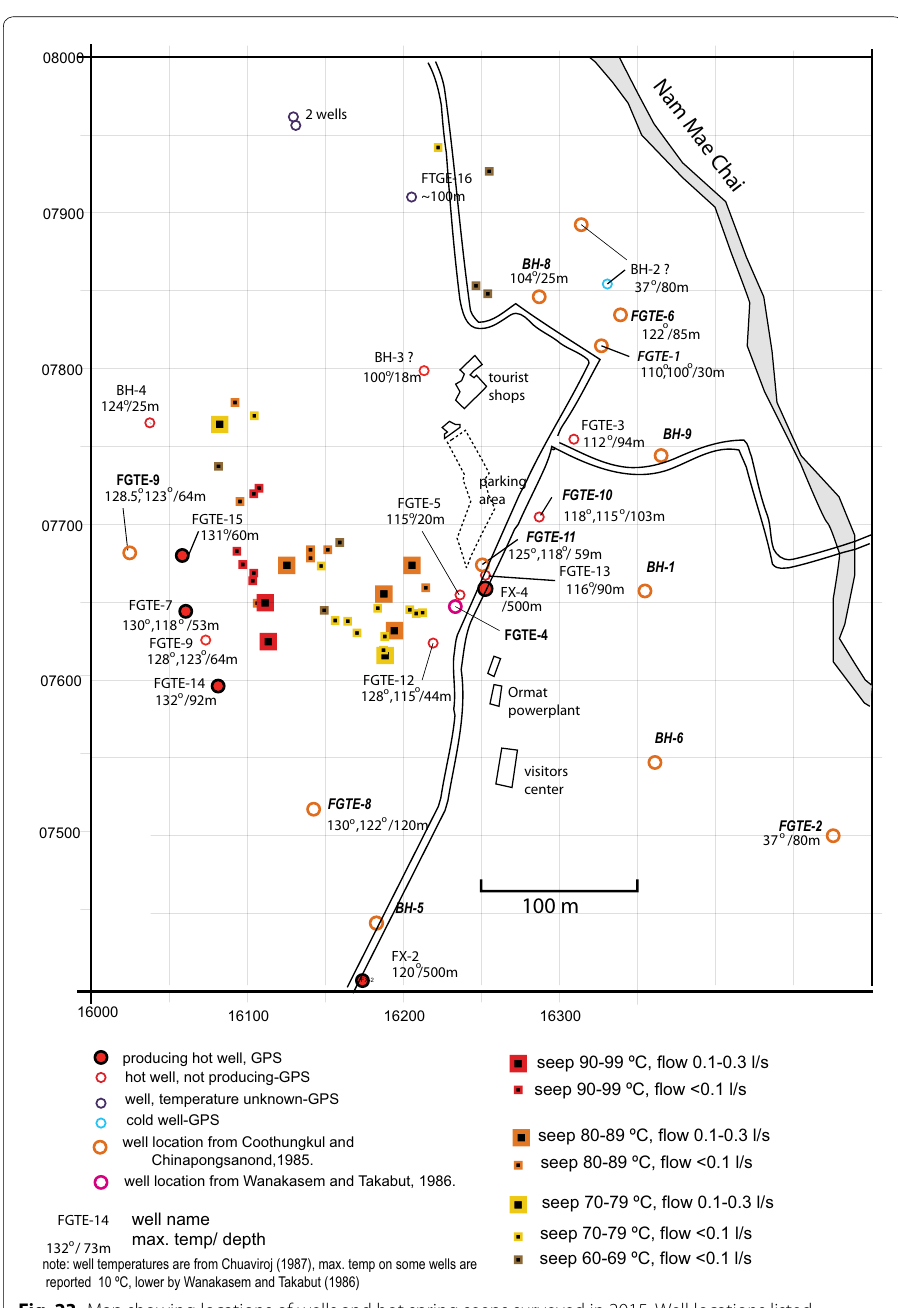
Fig. 23 Map showing locations of wells and hot spring seeps surveyed in 2015. Well locations listed in Table 1. Grid coordinates are UTM, WGS-84. Lower left corner (0516000E, 2207400N) corresponds to 99.152929ºE, 19.963050ºN